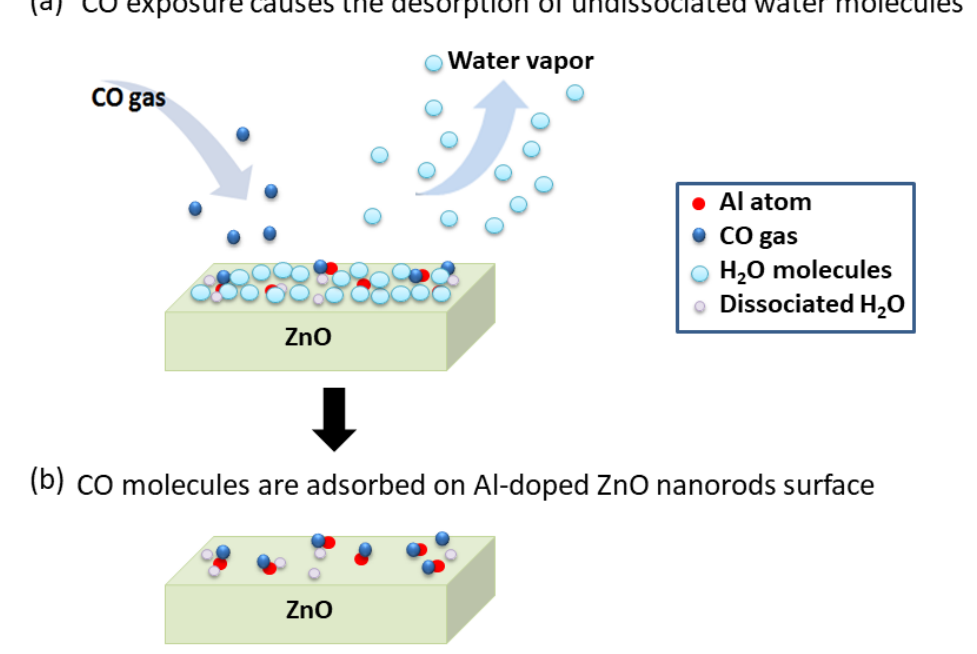
Figure 8. The possible mechanism of CO adsorption on Al-doped ZnO nanorod-coated microcantilever surface. Here, Al atoms (red circles in Figure 8) replaced Zn atoms on the topmost layer of the slab due to the fact that bonding between Zn and O in ZnO crystal lattices is weaker than that those between Zn–Al [13]. ( a ) CO exposure causes the desorption of undissociated H 2 O molecules, and ( b ) simultaneously, CO molecules are absorbed on the Al-doped ZnO nanorod surface.